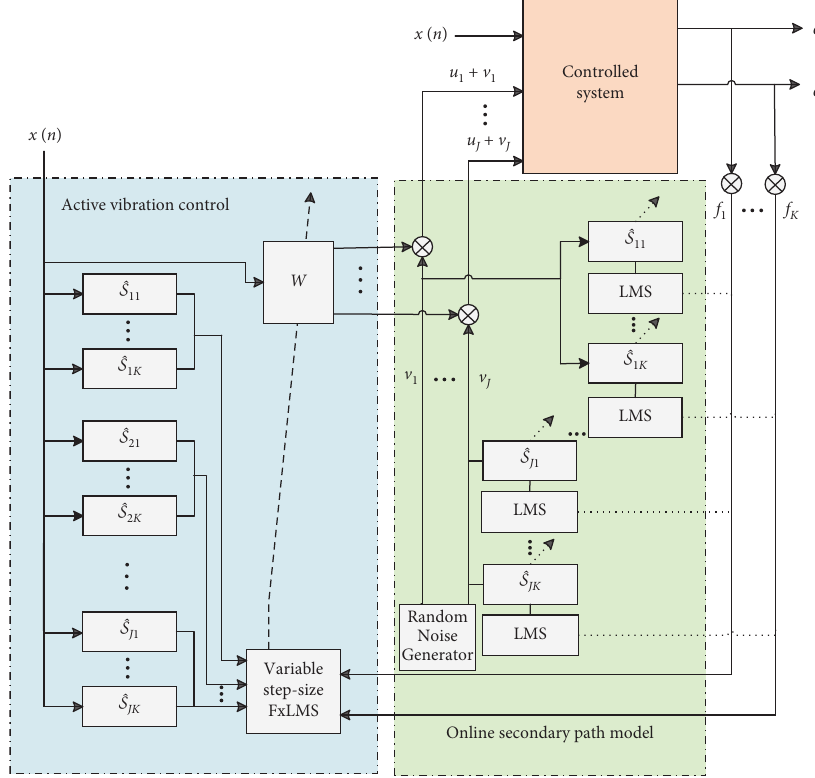
Figure 9: Multichannel variable-step-size FxLMS algorithm active vibration control